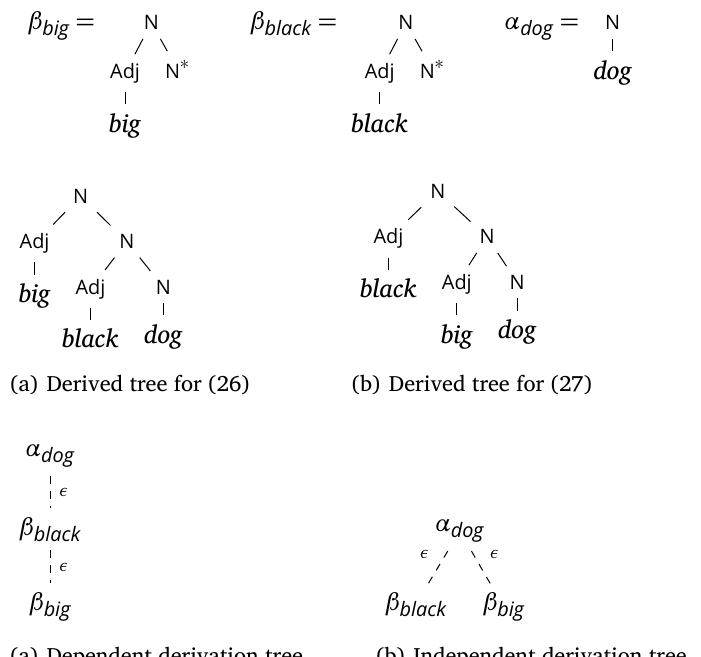
Figure 25: Alternative notions of derivation